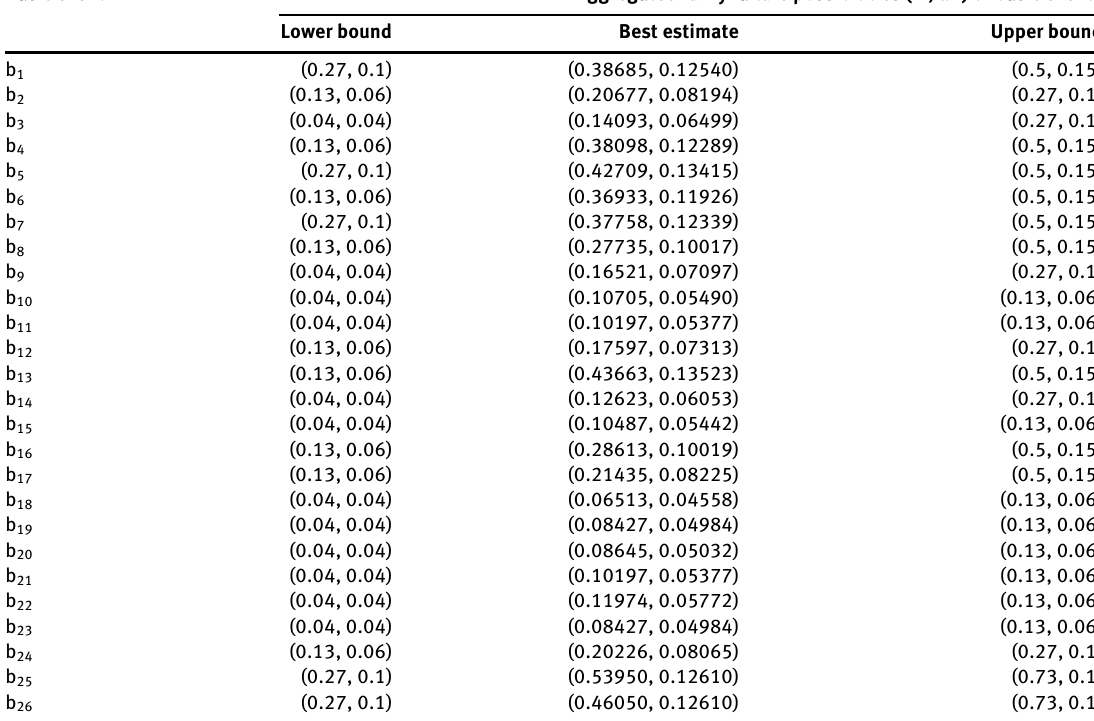
Table 8: The Best Estimate, Lower Bound, and Upper Bound Fuzzy Possibilities of Basic Events by Aggregation of Expert Opinions.